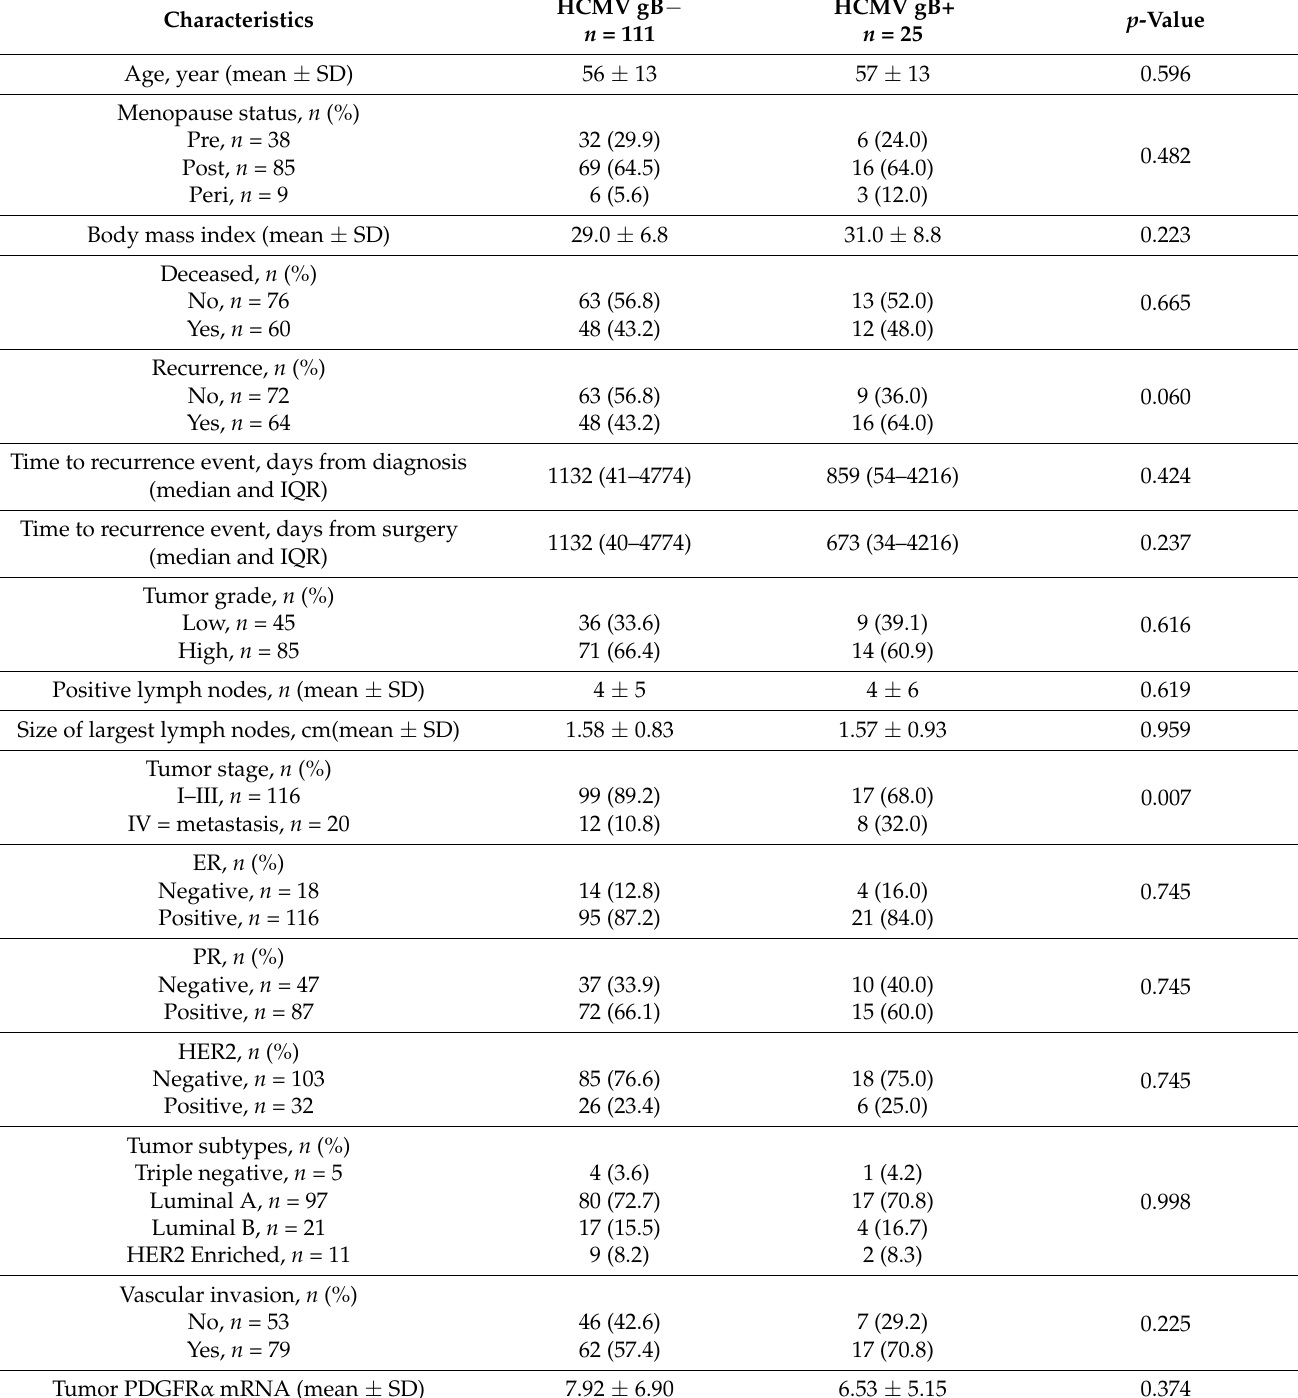
Table 3. HCMV gB DNA negative and positive breast tumors: univariate analysis of patient characteristics.